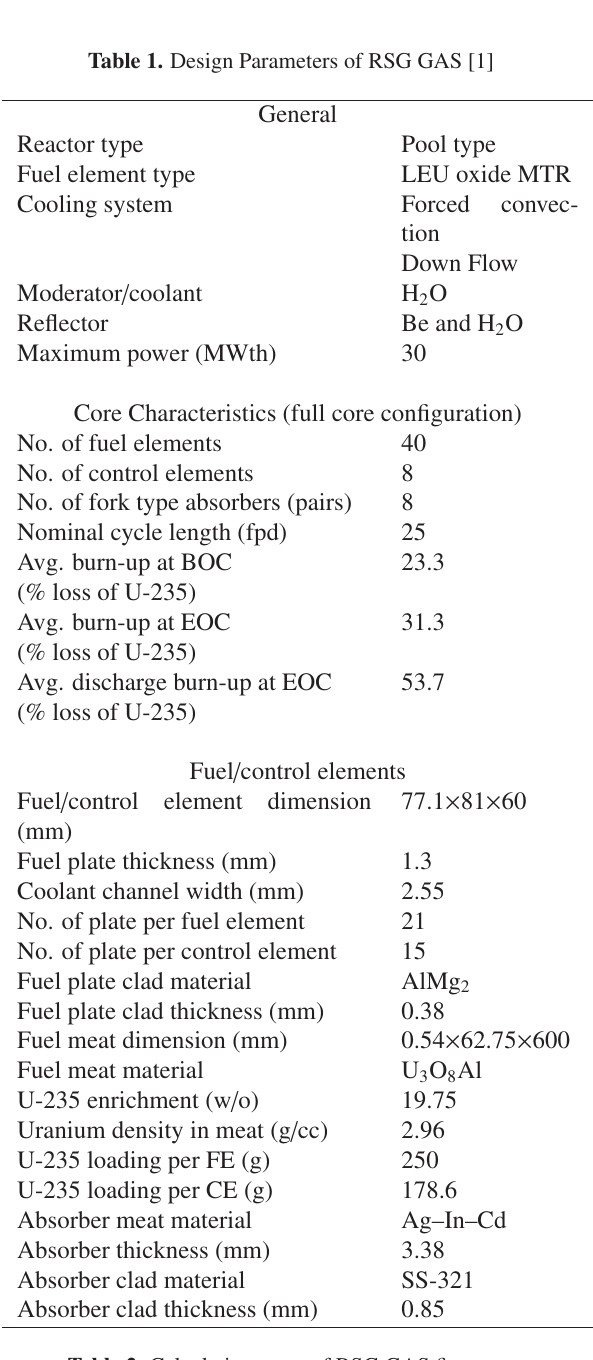
Table 2. Calculation cases of RSG GAS first core